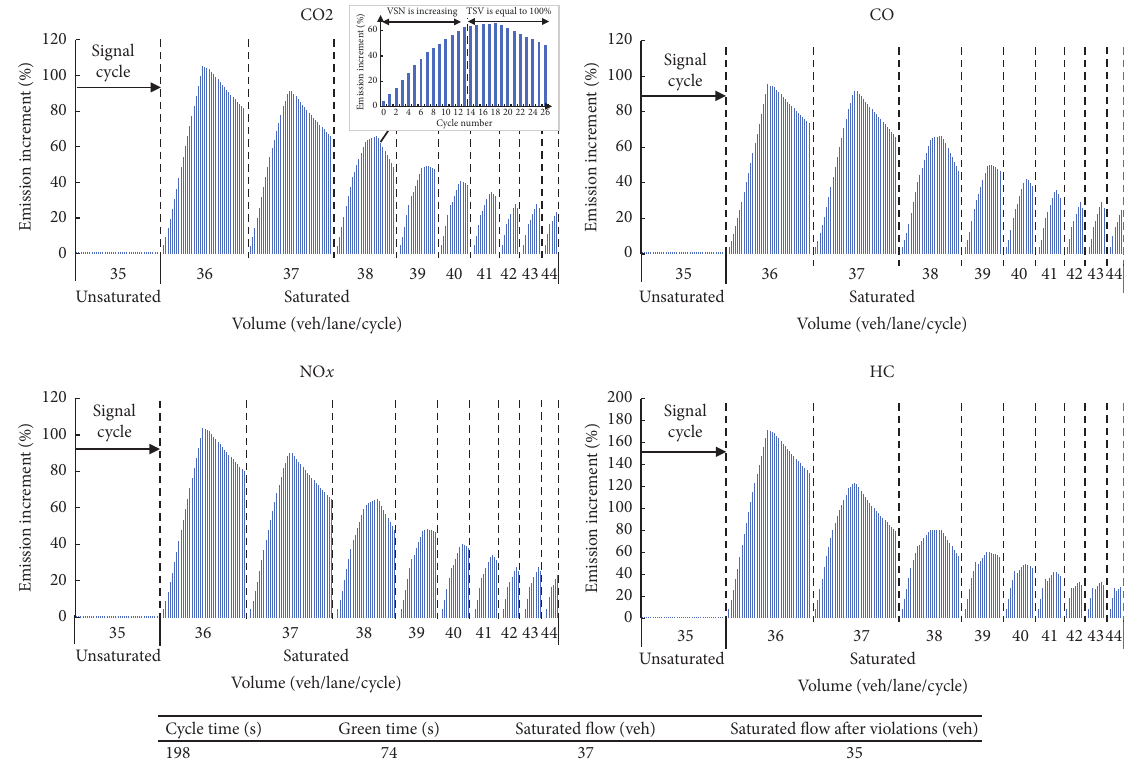
Figure 13: Emission increment after violations for saturated/unsaturated conditions as cycle